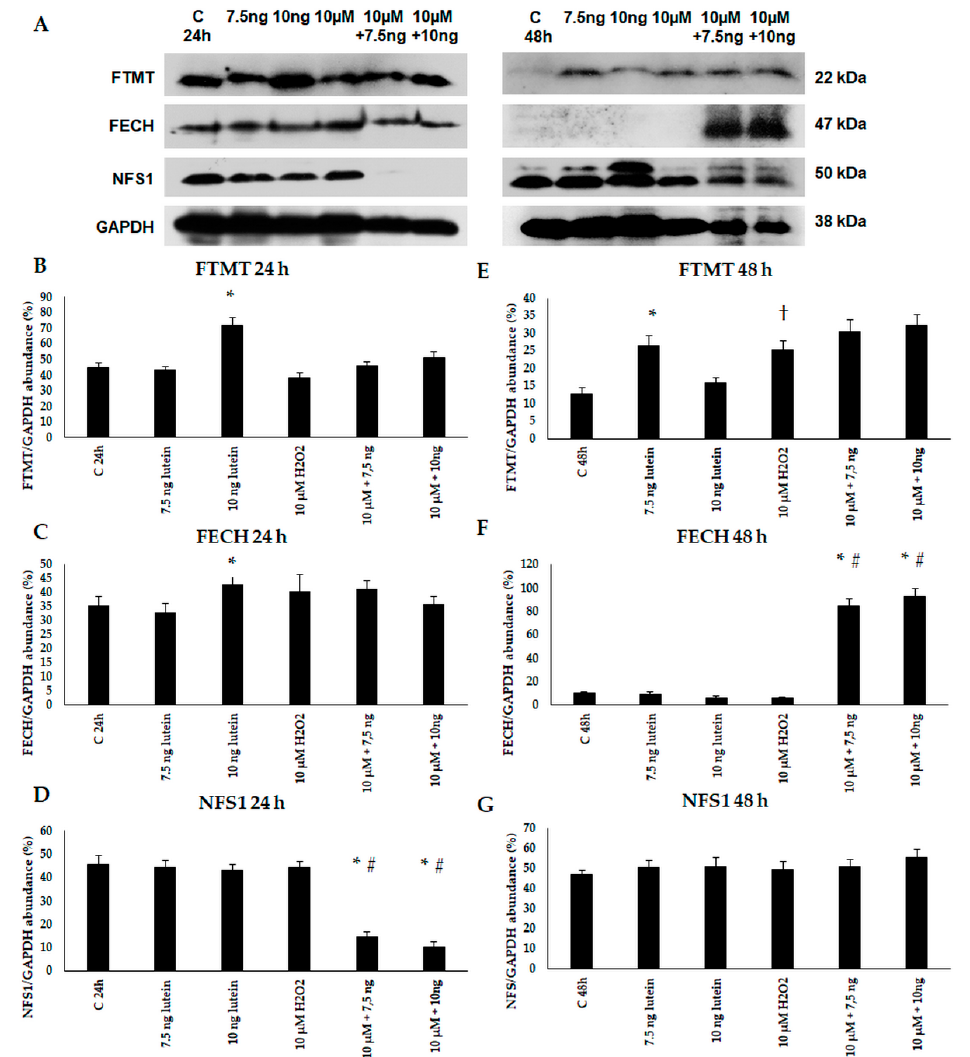
Figure 11. ( A ) Western blot analyses of mitochondrial proteins FTMT, FECH and NFS1 in lutein and in H 2 O 2 -treated BV-2 cells at 24 and 48 h. GAPDH was used as loading control. ( B – G ) Optical density analyses of FTMT, FECH and NFS1 in BV-2 cells at 24 and 48 h. The columns represent mean values and error bars represent standard deviation (SD) of three independent determinations ( n = 3). * indicates statistical significance of lutein treatments versus controls; † indicates statistical significance of H 2 O 2 -treated cells compared to controls; # indicates statistical significance of combined (lutein with H 2 O 2 ) treatments compared to H 2 O 2 treatments; the level of significance was p < 0.05. Abbreviations: C marks the appropriate absolute controls at 24 and 48 h; 7.5 ng means 7.5 ng/ µ L of lutein; 10 ng means 10 ng/ µ L of lutein; 10 µ M refers to 10 µ M H 2 O 2